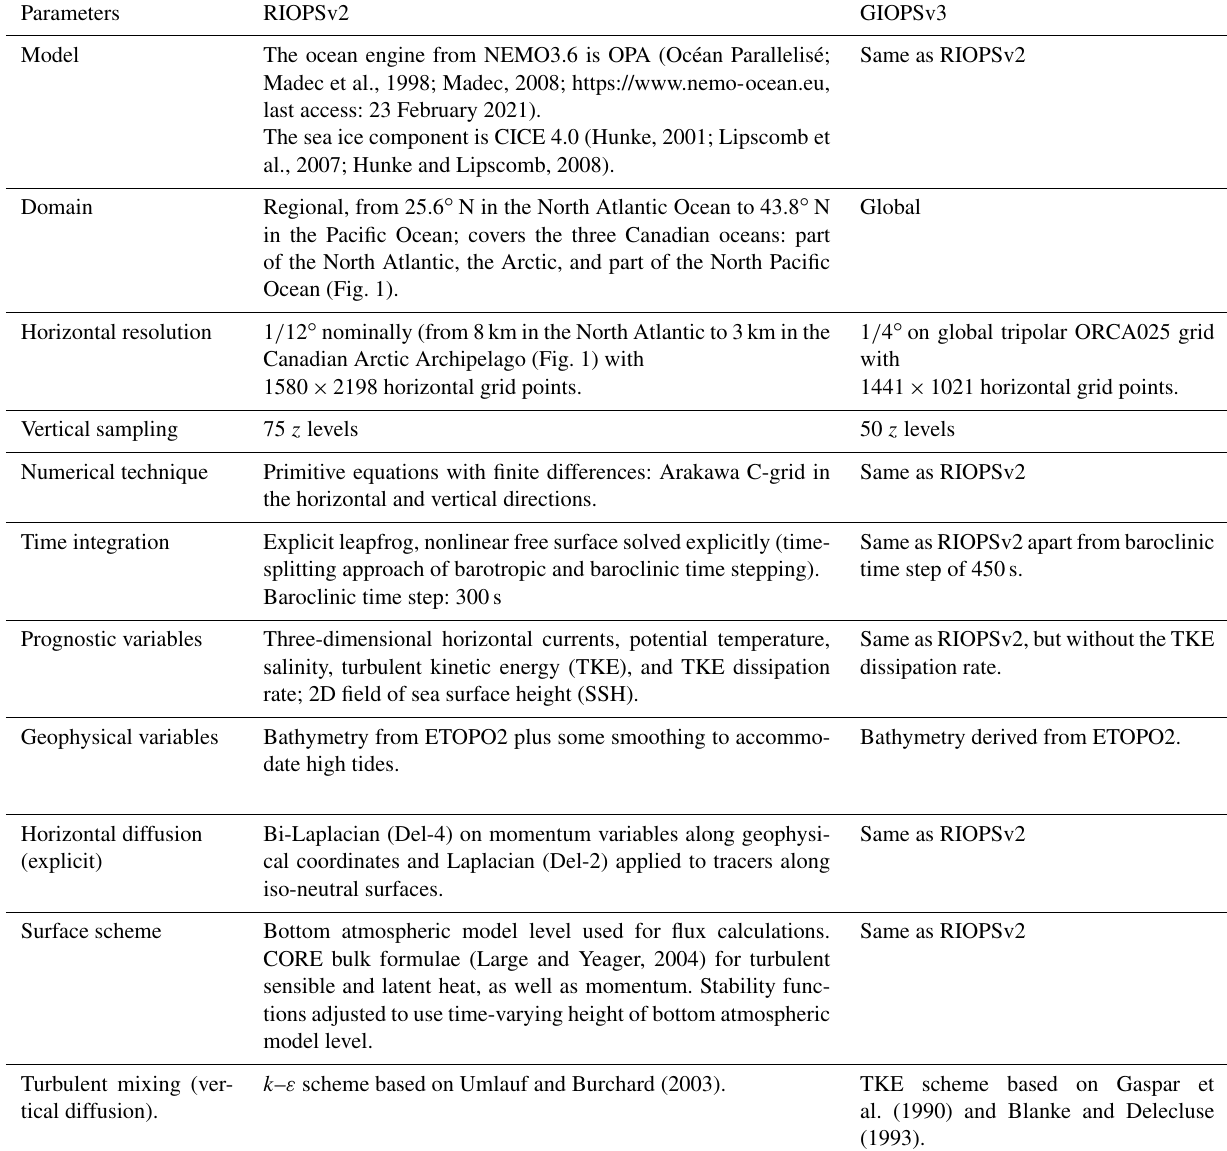
Table 2. Model parameters used in RIOPSv2 and GIOPSv3. Parameters RIOPSv2